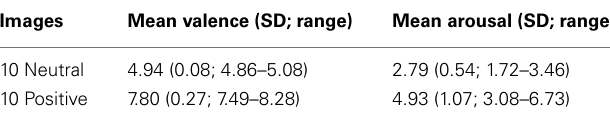
Table 1 |The valence and arousal ratings of the IAPS images